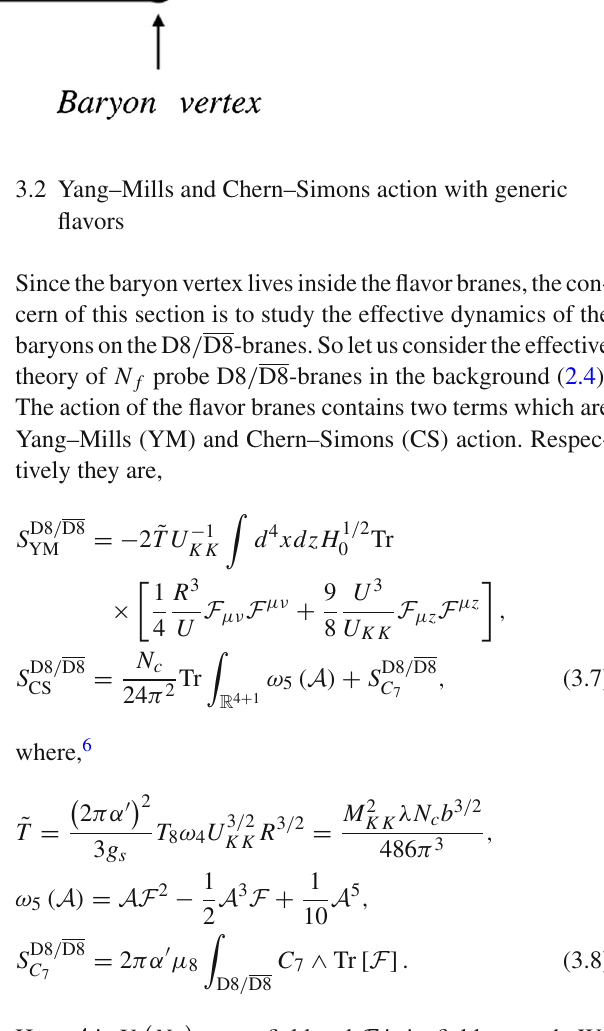
Fig. 1 The bubble configuration of the D0–D4 geometry in the τ − U plane where τ is compactified on S 1 . This background (cigar) is produced by N c D4-branes with N 0 smeared D0-branes. The flavor D8 / D8-branes live at antipodal position of the cigar represented by the blue line. Particularly we will consider the case of N f = 3 in this paper. The baryon spectrum is created by the baryon vertex (D4 (cid:5) -brane) living inside the flavor